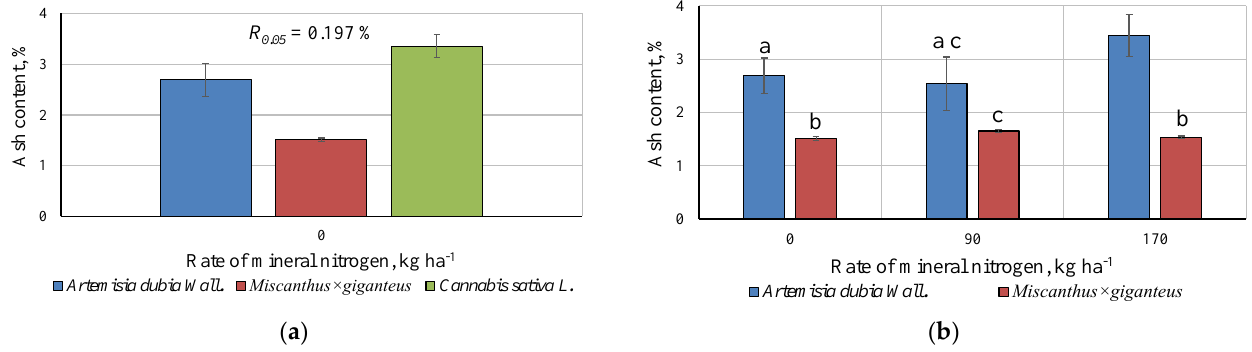
Figure 4. The dependence of ash content of above-ground crops parts of Artemisia dubia Wall., Miscanthus×giganteus and Cannabis sativa L. not fertilized ( a ), on mineral nitrogen fertilization ( b ) ( R 0.05 ( A. dubia ) = 0.152%, R 0.05 ( M. giganteus ) = 0.043%, R 0.05 ( A. dubia × M. giganteus ) = 0.089%. a, b, c, there are no statistically significant differences ( p < 0.05) between the columns marked with the same letter, as assessed using the least significant difference.